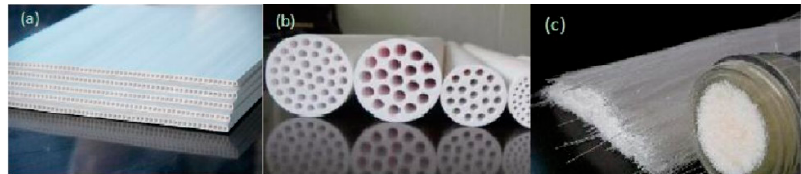
Figure 4. ( a ) Flat membrane; ( b ) tubular membrane; ( c ) hollow fiber membrane.